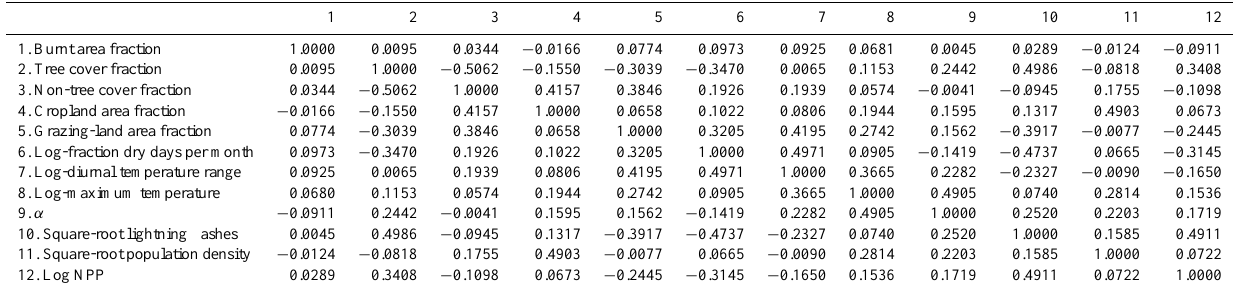
Table A1. Cross-correlation matrix of all variables used for model fitting. We show Spearman’s ρ